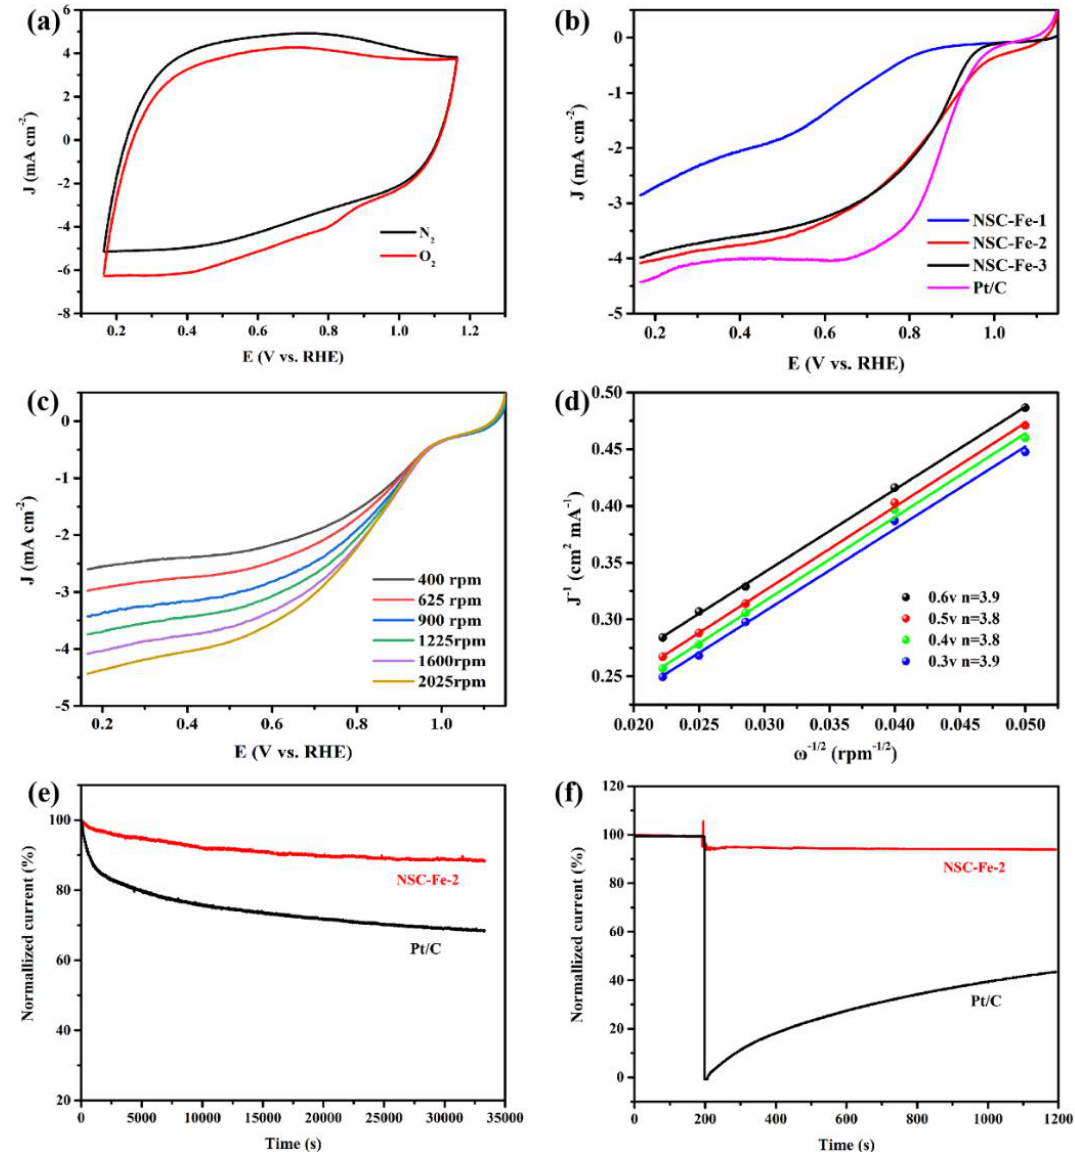
Figure 5. ( a ) The CV curves of NSC-Fe-2 in O 2 -saturated and N 2 -saturated 0.1 M KOH at 50 mV s −1 . ( b ) LSV curves of the NSC-Fe- x and Pt/C catalysts at 1600 rpm. ( c ) LSV curves for NSC-Fe-2 at various rotation rates. ( d ) K–L plots of NSC-Fe-2 at potentials from 0.6 to 0.3 V. ( e ) The durability tests of Pt/C and NSC-Fe-2. ( f ) The methanol crossover tolerance of Pt/C and NSC-Fe-2.